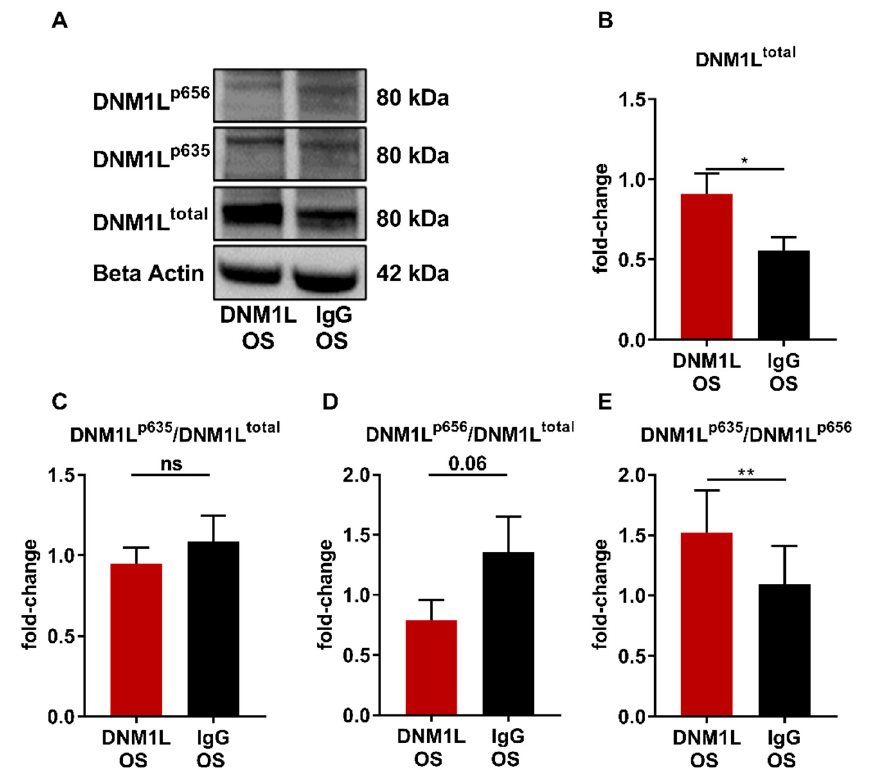
Figure 5. Anti-DNM1L Ab injection alters the phosphorylation of DNM1L. ( A ) Western blot detec- tion of DNM1L, total protein expression (DNM1L total ), phosphorylation of DNM1L at serine 635 (DNM1L p635 ), phosphorylation of DNM1L as serine 656 (DNM1L p656 ), and housekeeping protein